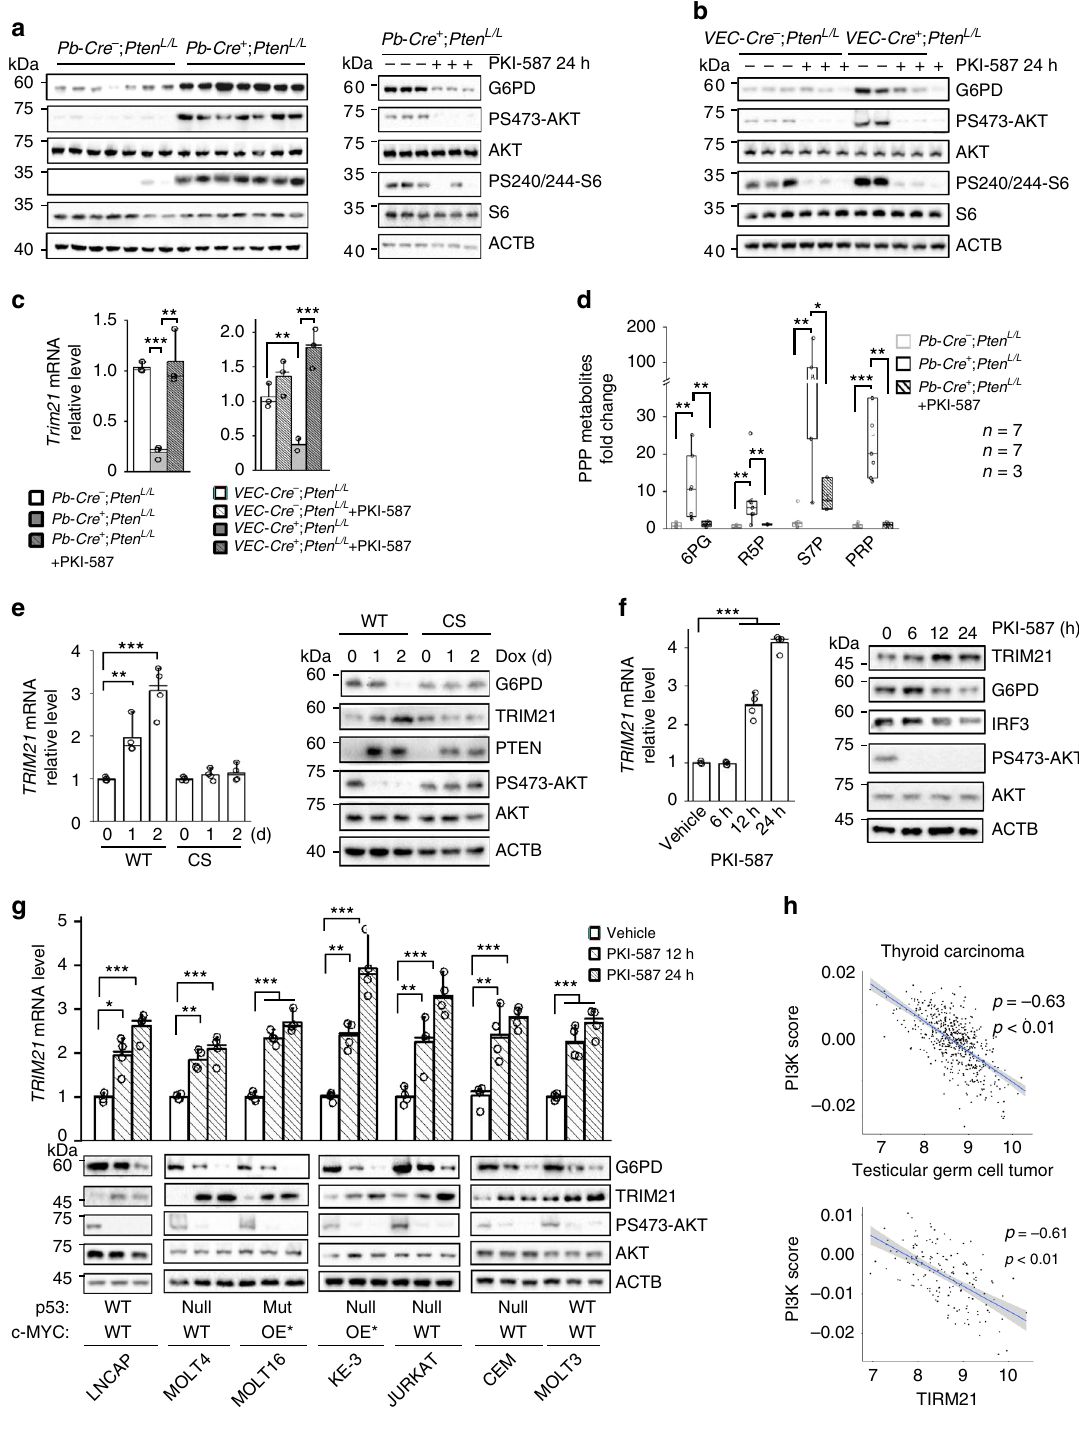
(Fig. 5a, left panel). FACS analysis further demonstrated that the aforementioned treatments led to similar levels of cell cycle blockage as well as apoptosis (Fig. 5a, middle and right panels). Since PI3K/AKT plays a central role in cell proliferation and survival, we hypothesized that the PPP may feedback regulate PI3K/AKT activity. Indeed, 6-AN treatment effectively inhibited AKT phosphor- ylation and activation of its downstream effector S6, similar to PKI-587 treatment (Fig. 5b, left panel). Importantly, in